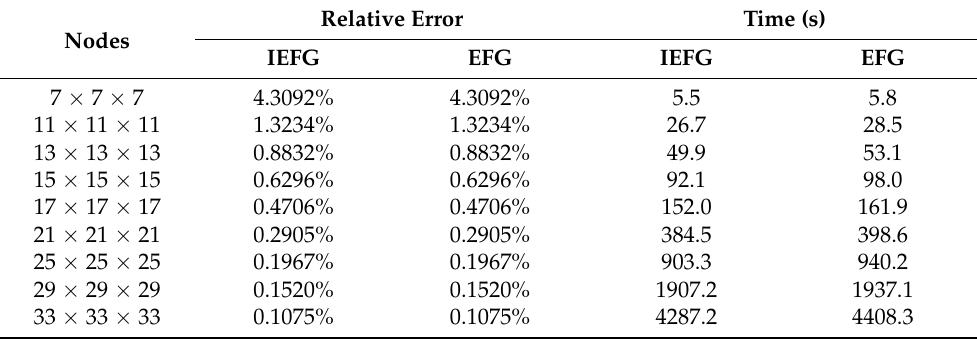
Table 1. Relative errors and CPU times of the improved element-free Galerkin (IEFG) and element-free Galerkin (EFG) methods with the increase in node